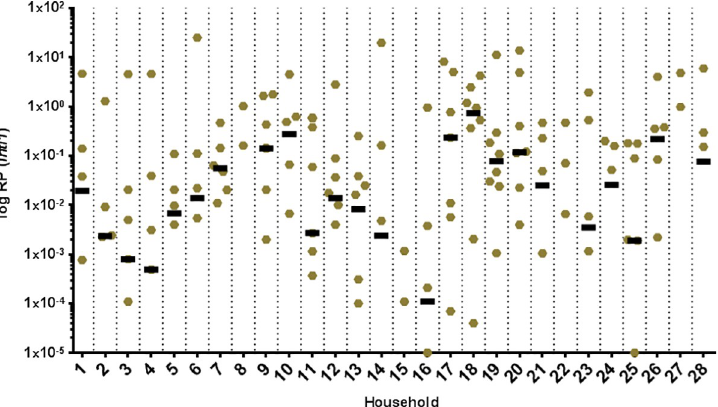
Fig 1. Relative prevalence (RP) of class 1 integrons across household environments. Bars depict the median. Copies/mL of intI1 and 16S rDNA gene were determined by qPCR and the relative prevalence of intI1 was calculated. The median value of toothbrushes is 0 and thus not depicted.